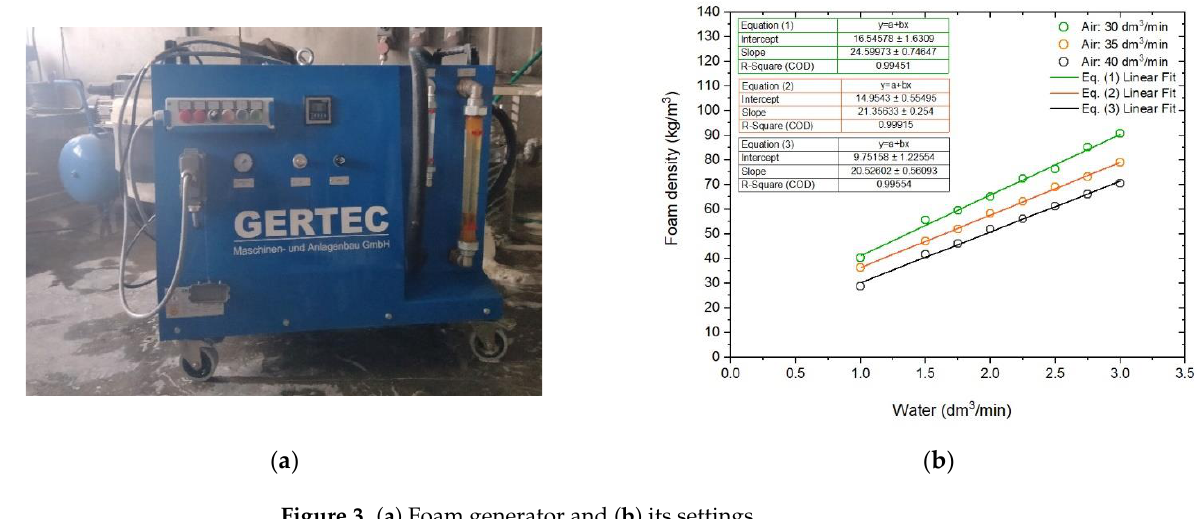
Figure 3. ( a ) Foam generator and ( b ) its settings.